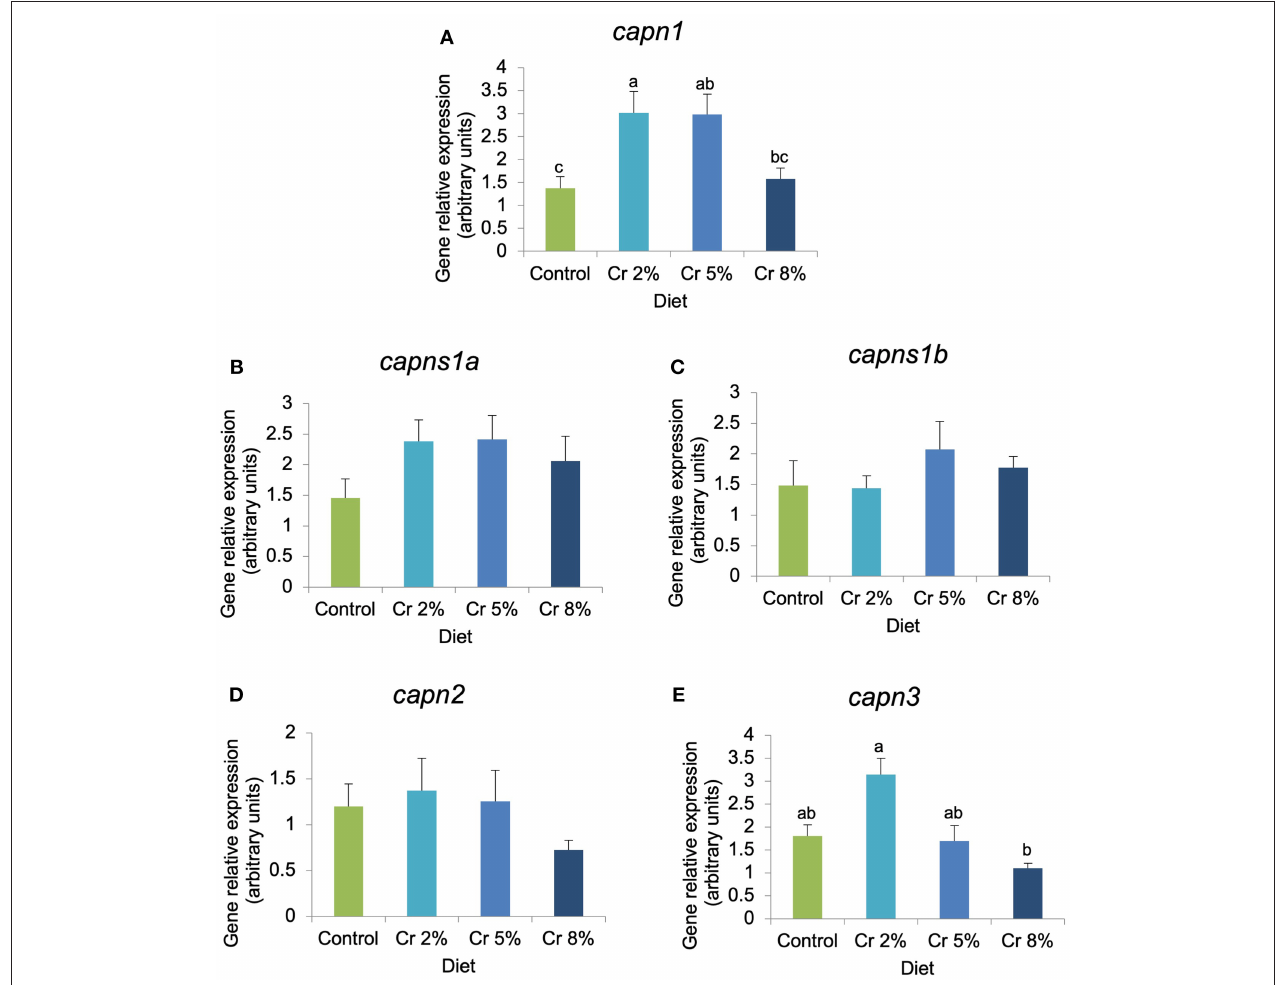
FIGURE 4 | (A–E) Relative expression of genes involved in proteolysis in gilthead seabream juveniles fed the control and the experimental diets (2, 5, and 8% creatine). Different letters indicate significant differences between groups. P < 0.05. Error bars indicate the standard error for each treatment ( n =